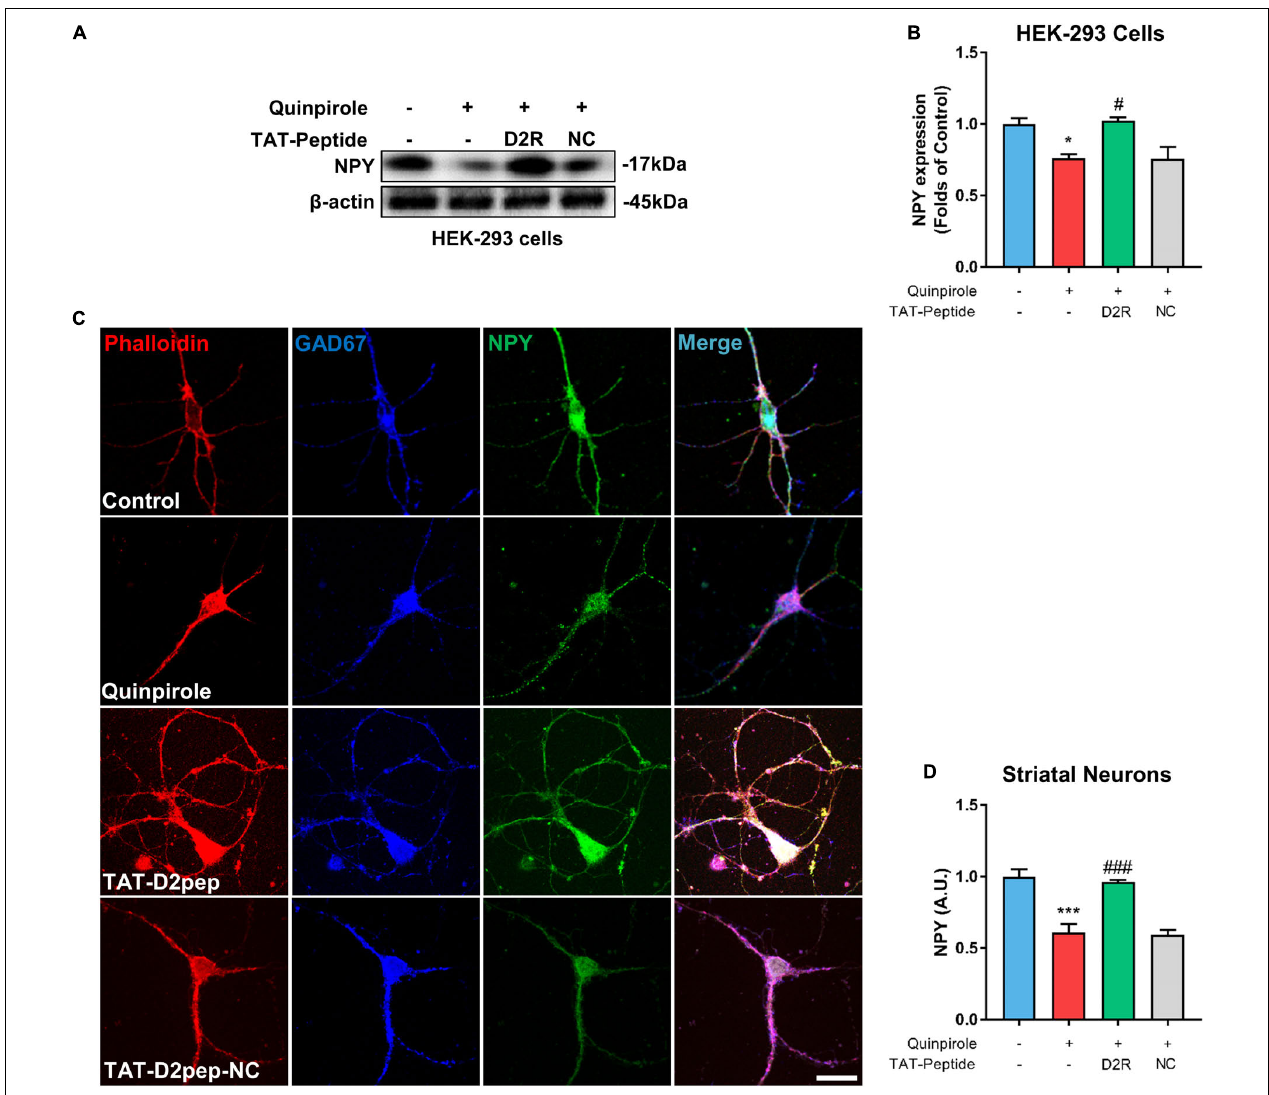
FIGURE 5 | TAT-D2pep protects neurites through upregulating NPY in striatal GABAergic neurons. (A,B) Western blot analysis showed that TAT-D2pep but not TAT-D2pep-NC inhibited downregulation of NPY in HEK-293 cells expressing D2R-EGFP and DISC1 mCherry; n > 3 per group. (C,D) Triple-immunostaining for phalloidin-actin, NPY and GAD67 in primary striatal neurons. TAT-D2pep blocked quinpirole-induced downregulation of NPY in striatal GABAergic neurons, accompanied by normal neurite growth. * P < 0.05 and *** P < 0.001 versus control, # P < 0.05 and ### P < 0.001 versus quinpirole by one-way analysis of variance (ANOVA) with post hoc Tukey